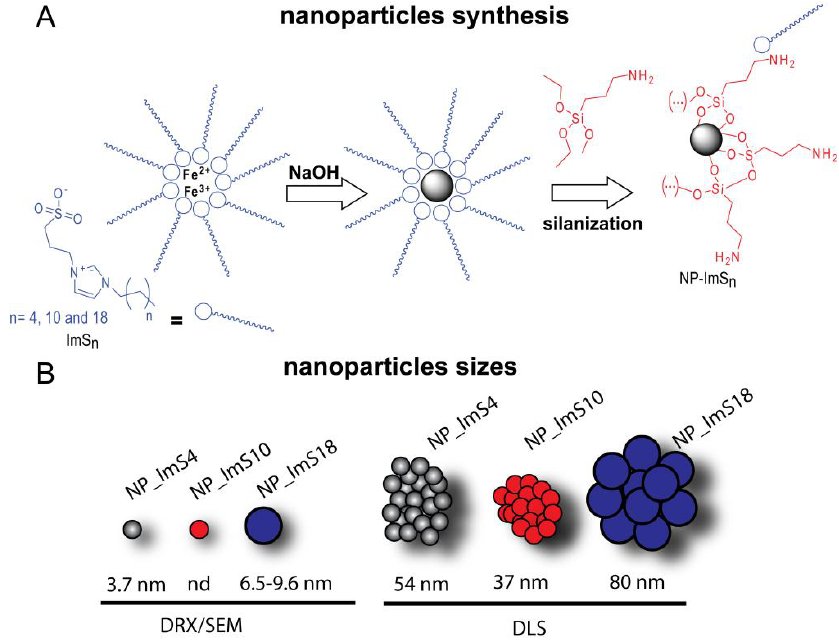
Figure 1. ( A ) Scheme of NP-ImSn synthesis using reverse micelles made of zwitterionic surfactants ImSn (n = 4, 10 and 18); ( B ) Typical sizes obtained for the particles using different analyses.